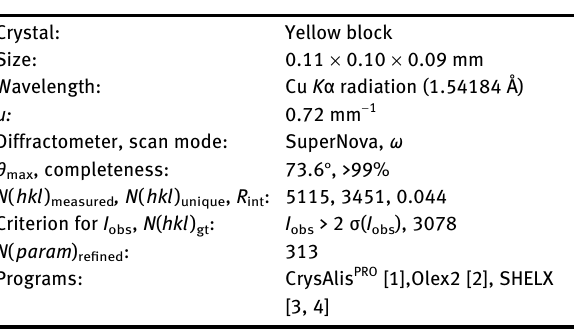
Table  : Data collection and